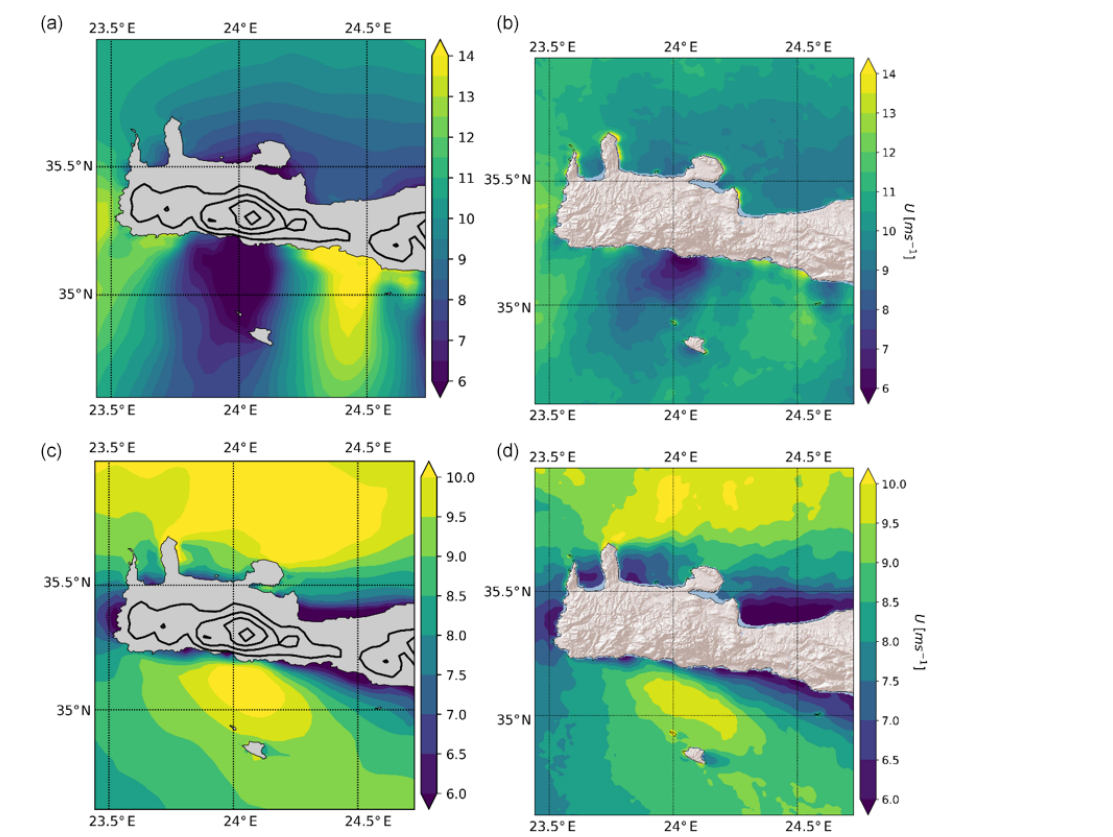
Figure 10. Mean wind speeds (ms − 1 ) from WRF (a, c) and SAR (b, d) at 10m. (a, b) Northerly flow based on 59 collocated cases from 2002 to 2018. (c, d) Westerly flow based on 57 collocated cases from 2002 to